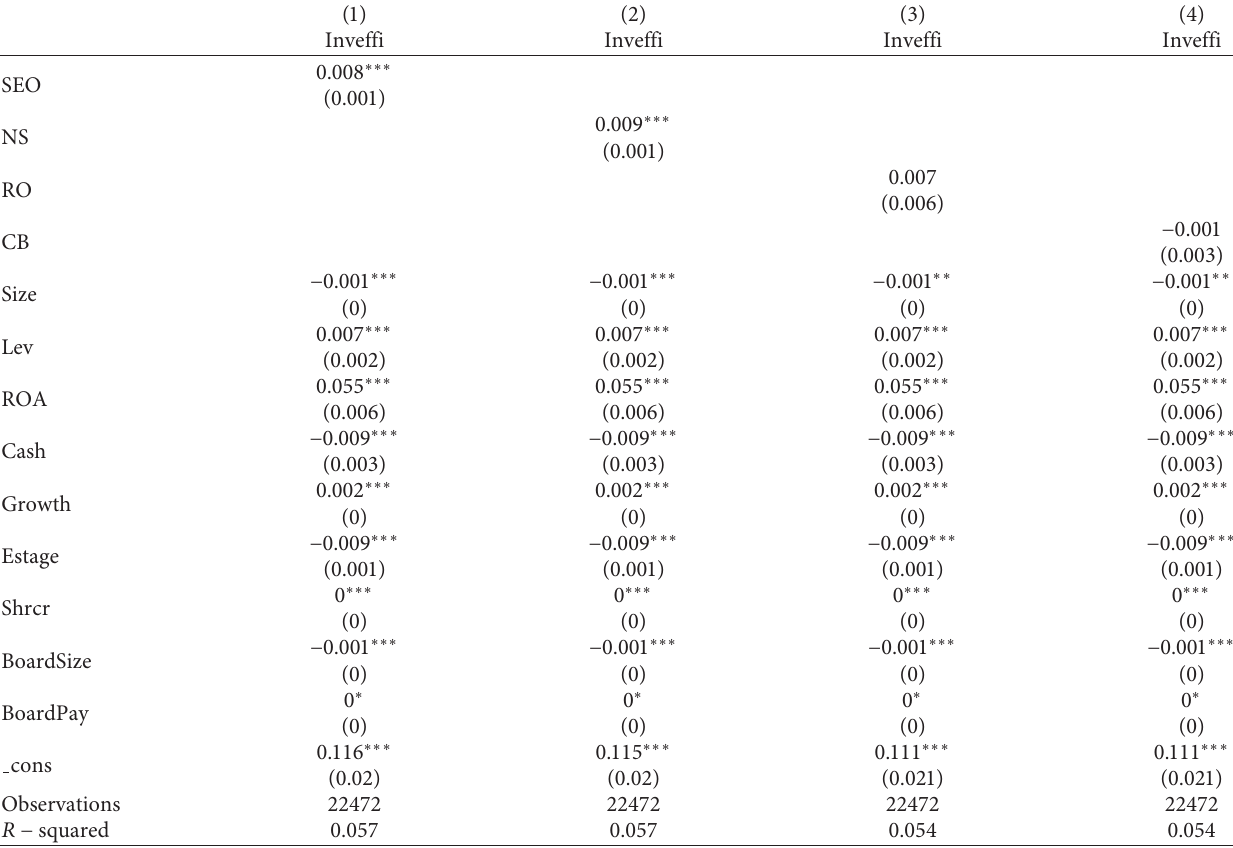
Table 8: Regression results of the relationship between SEO and investment efficiency (robustness